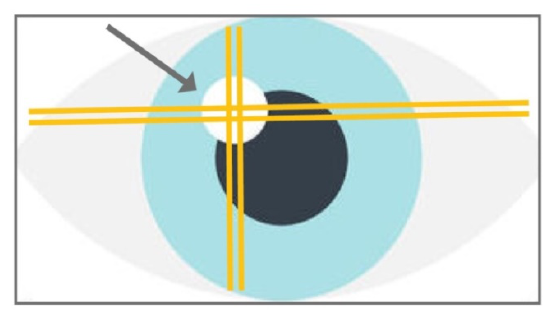
Figure 2. Light is coordinated towards the focal point of the eyes